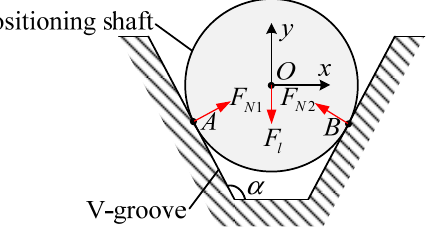
Figure 5. Schematic diagram of positioning shaft and V-groove.